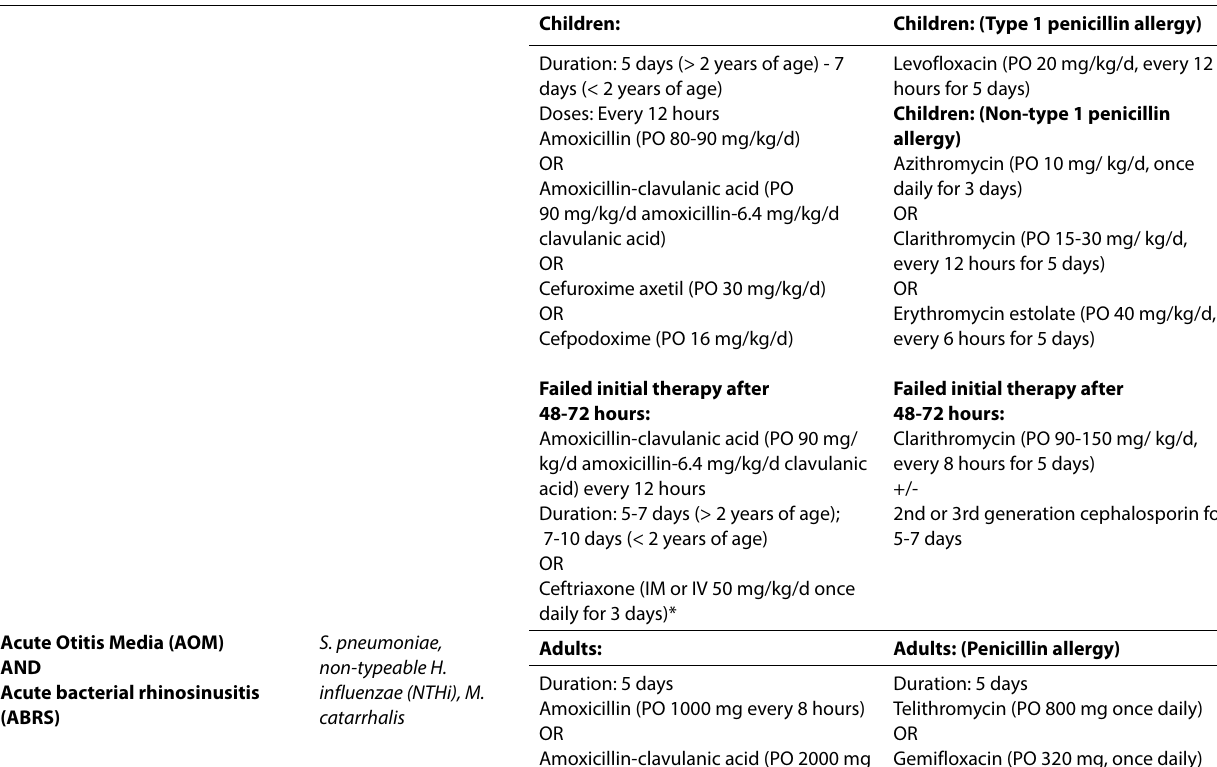
Table I. Main antibiotic treatment options for Upper and Lower Respiratory Tract Infections of bacterial origin. 1,2-8,10,12-19,21,23,25-27